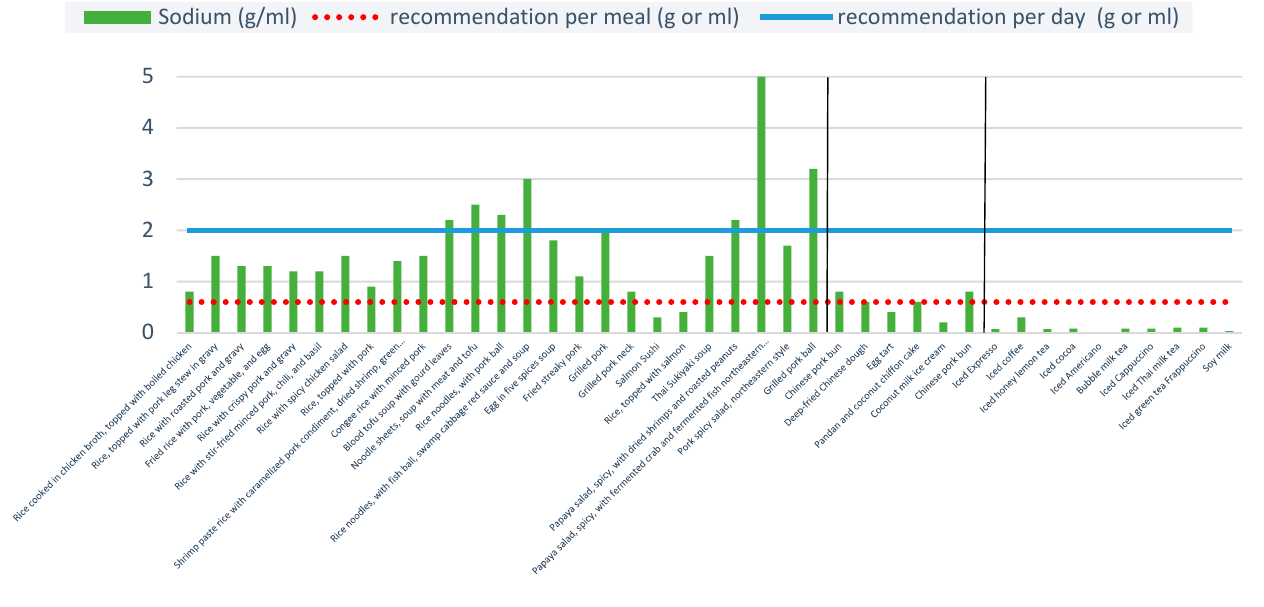
Figure 5. Total sugar content per portion of 40 menu items. Note: Two vertical blacks line separate